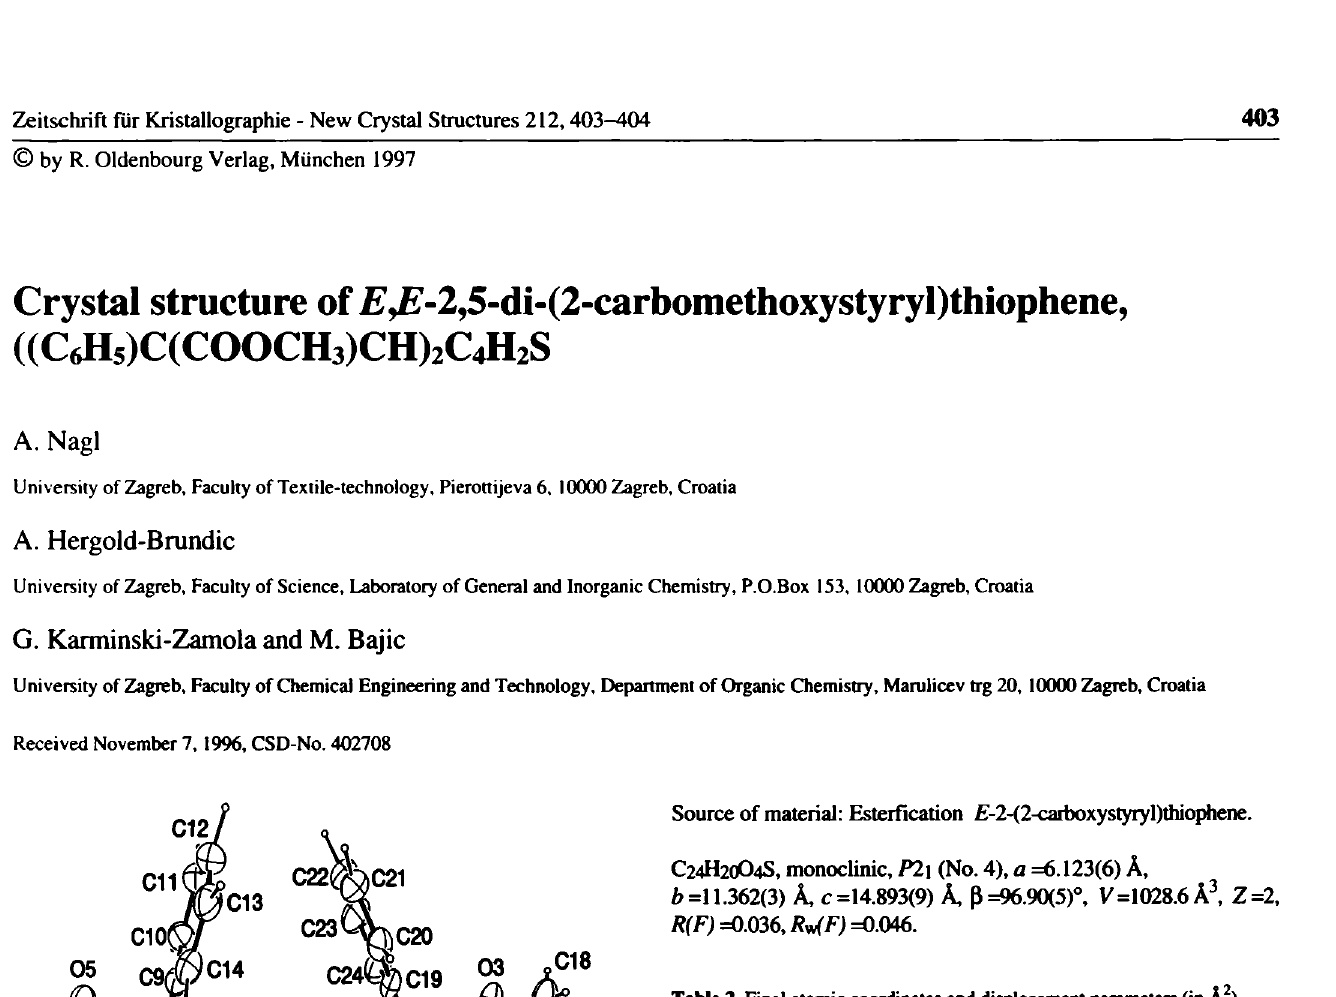
Table 2. Final atomic coordinates and displacement parameters (in Â 2 )